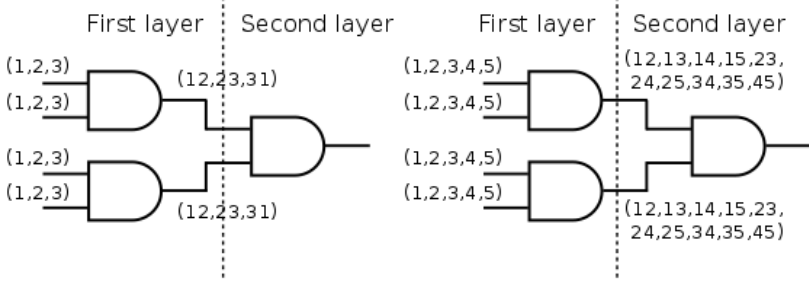
Figure 6: Quartic operation with (left) first-order sharing and (right) second-order sharing for the first round/layer of